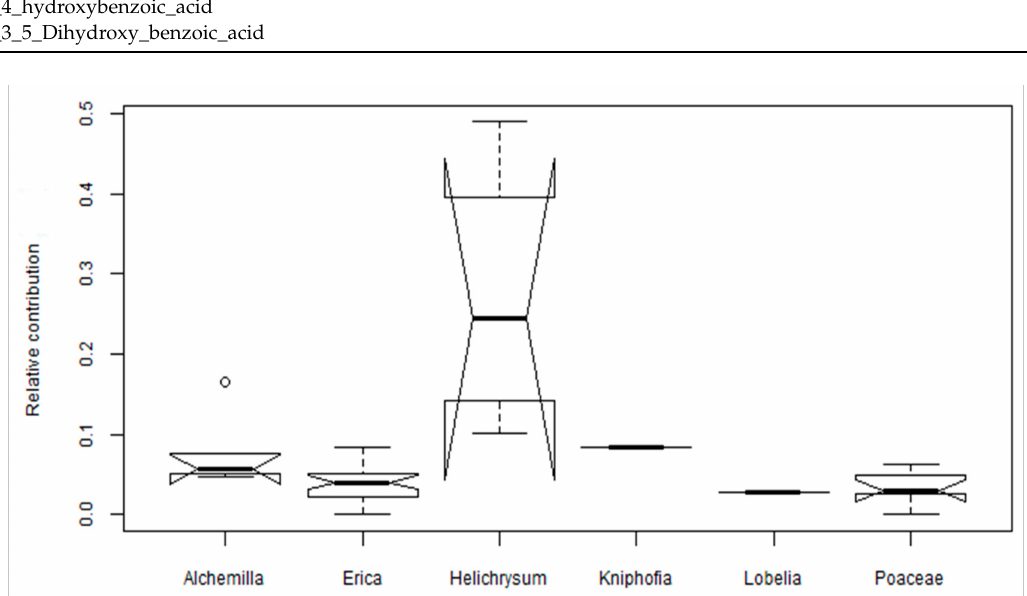
Figure 3. Notched box plots show the relative abundance of p -hydroxy phenols in the dominant plant species of the Bale Mountains. The box plots indicate the median (solid line between the boxes), interquartile range (IQR) with upper (75%) and lower (25%) quartiles and possible outlier (white circles). The notches display the confidence interval around the median within +/ − 1.57 * IQR /